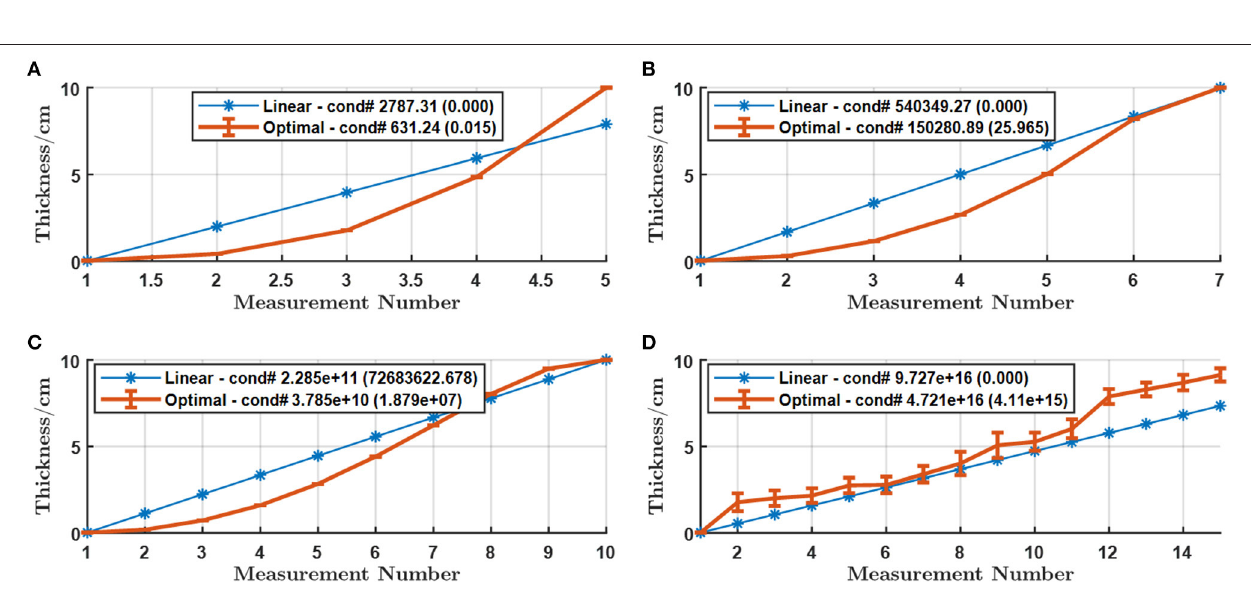
FIGURE 3 | Optimal thicknesses for the non-linear arrangement against the best linear arrangement for (A) M measurements with Al within the range [0.02, 10] cm. The error-bars in the curve stand for the standard deviation of the thicknesses while the numbers in the legend are the means and standard deviations of the condition numbers from 30 runs.